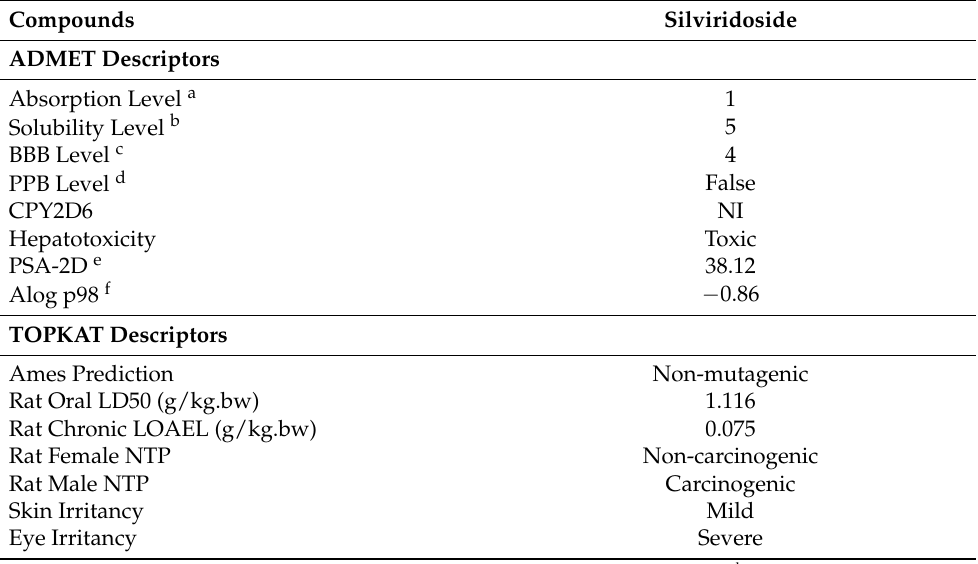
Table 4. Absorption, distribution, metabolism, excretion, and toxicity (ADMET/TOPKAT) properties of